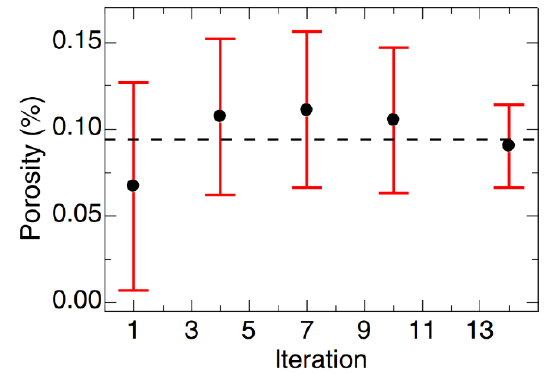
Figure 5. Results from porosity measurements performed on 3D printed samples. Each point represents the average porosity (in percentage) found in six samples fabricated in five particular iterations. Red bars indicate standard deviation from this value. The dashed line represents the average porosity obtained from these five values [14]. Copyright 2014. Adapted with permission from Elsevier Science Ltd. under the license number 4803690436753 (Figure 5 [14]), dated 7 April 2020.